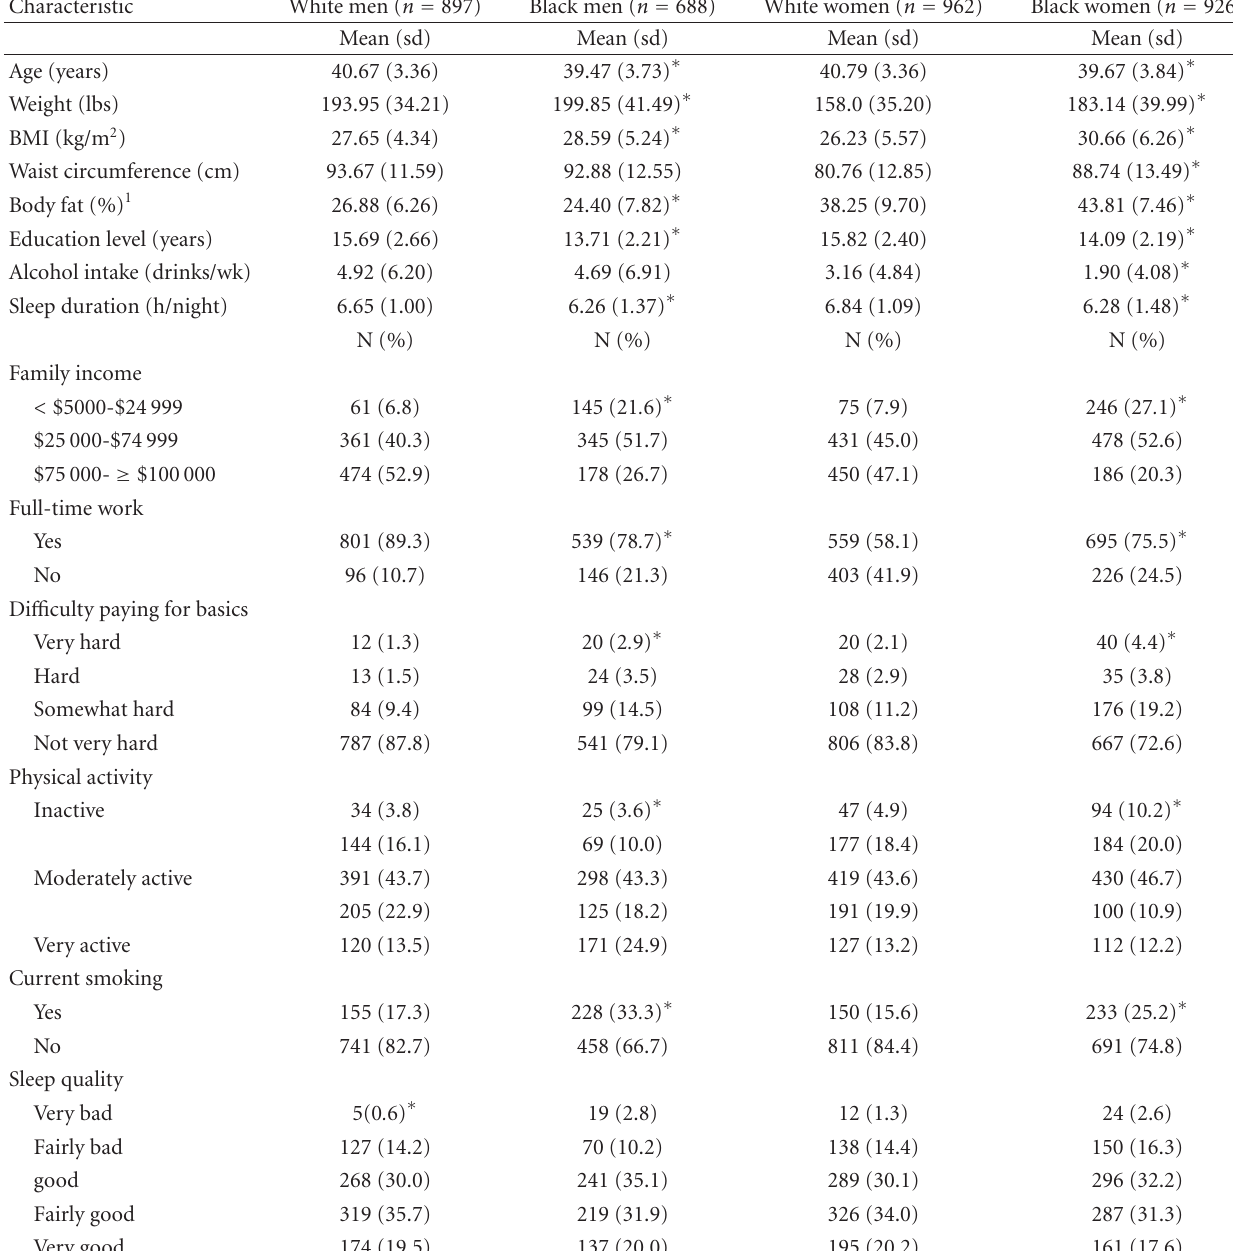
Table 2: Participant characteristics by gender and